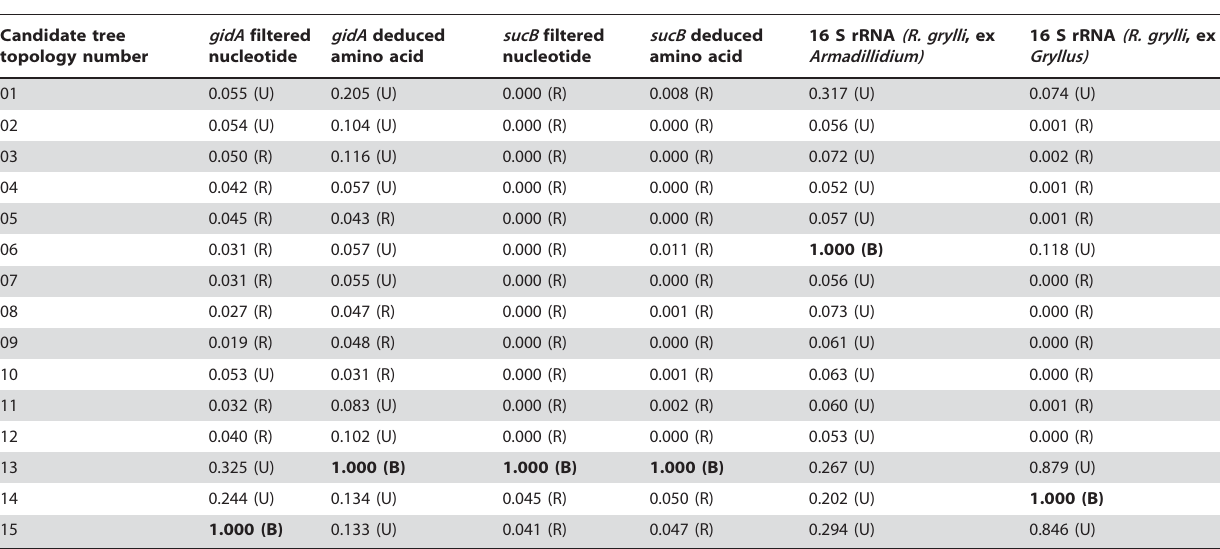
1sKH test results across the 15 candidate tree topologies presented in Figure 4B with respect to different marker sequence alignments. For the protein-encoding marker genes gidA and sucB both the hypervariability filtered nucleotide and the deduced amino acid sequence levels were explored. For the 16 S rRNA marker, two data sets comprising sequences from different Rickettsiella grylli strains were analyzed. The p-values attributed to a tree topology by the 1sKH test are interpreted under assumption of an exogenous 5% significance threshold as ‘‘B’’ for a data set specific best tree, ‘‘U’’ for an unrejected second-best tree, and ‘‘R’’ for a rejected tree. Data set specific best trees are indicated in bold type.